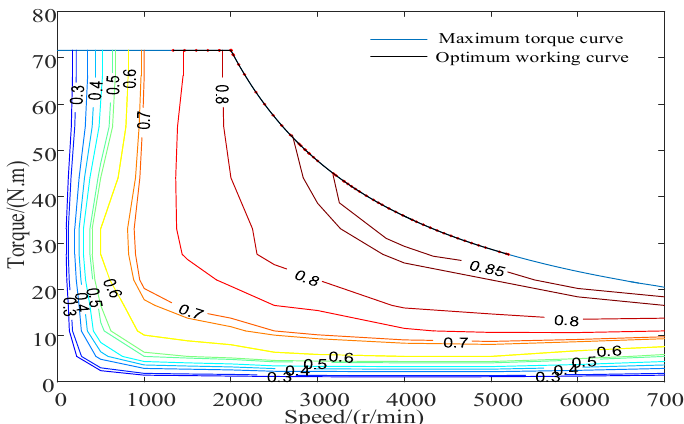
Figure 5. Optimal operating curve of engine.